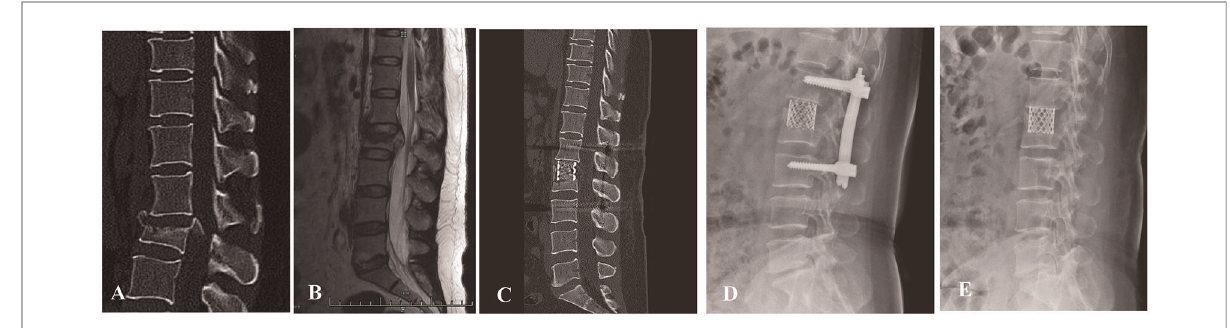
FIGURE 3 ( A,B ) preoperative sagittal CT scan and MRI images of a 42-year-old male patient with L2 burst fracture with nerve de fi cit. ( C ) Postoperative lateral CT image demonstrating good correction of kyphotic deformity via posterior instrumentation combined with AIPA anterior decompression and titanium cage placement. ( D ) An x-ray image was taken 3 months after surgery. ( E ) x-ray image demonstrating that the posterior screw – rod system had been removed.